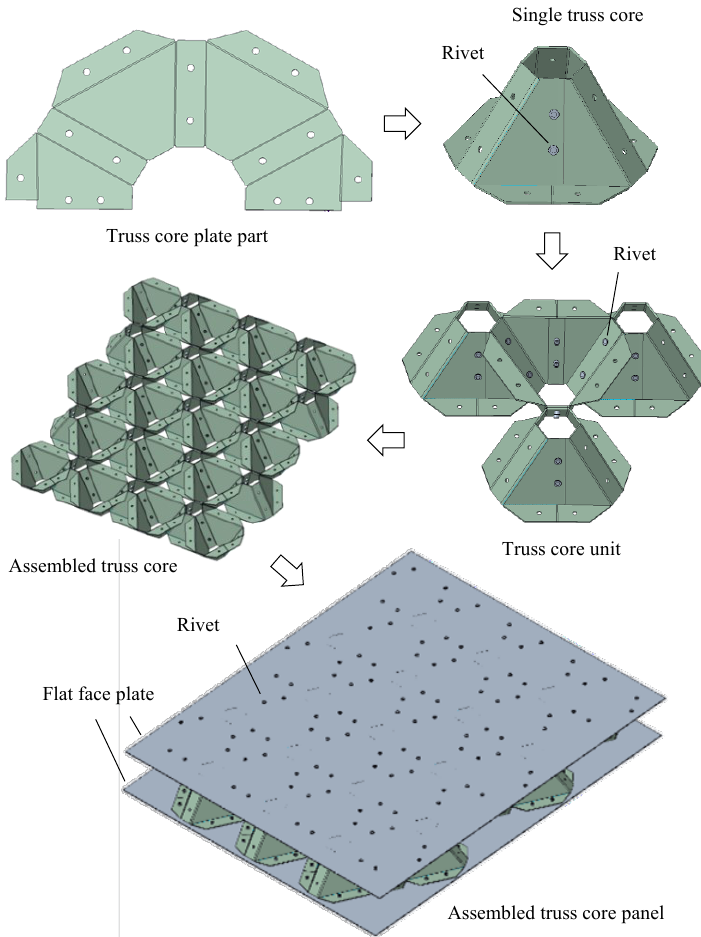
Figure 5. Creation process of assembled truss core panel structure. J. Manuf. Mater. Process. 2023 , 7 , 29